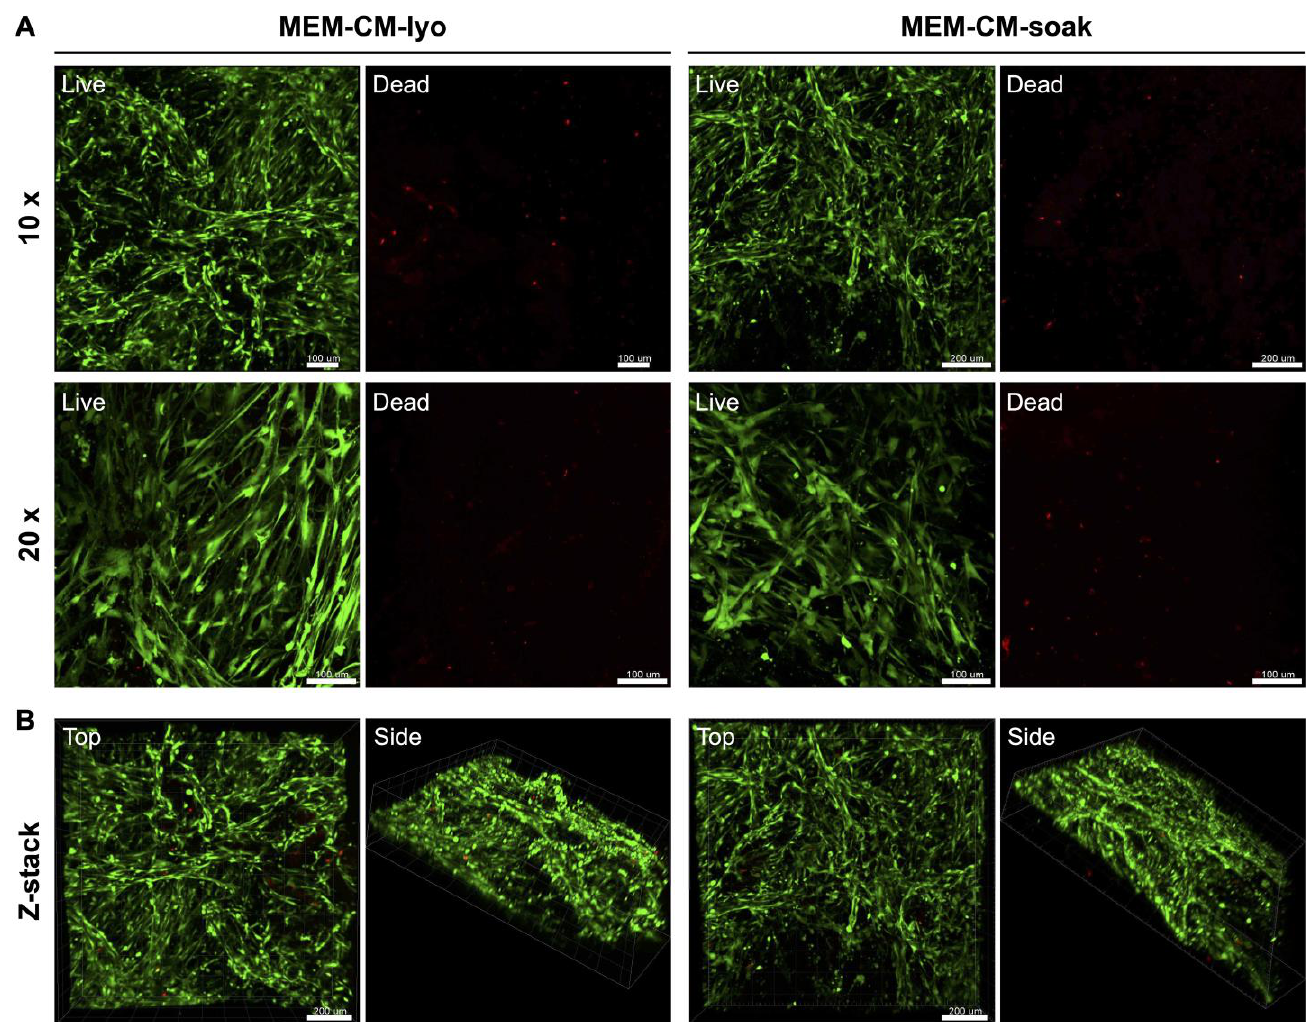
Figure 1. Evaluation of cell viability on MEM-CM. Representative 2D ( A ) and 3D ( B ) confocal images of rMSC viability (live/dead assay) on CM functionalized MEM either soaked (CM-SOAK) or lyophilized (CM-LYO) after 3 days. Scale bars: 100 μ m (A) and 200 μm (B).